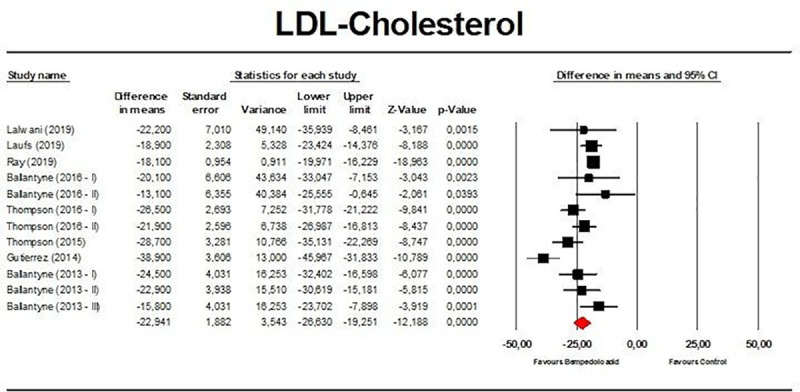
Forest plot displaying mean difference and 95% confidence intervals for the effect of bempedoic acid on plasma levels of low-density lipoprotein (LDL) cholesterol.